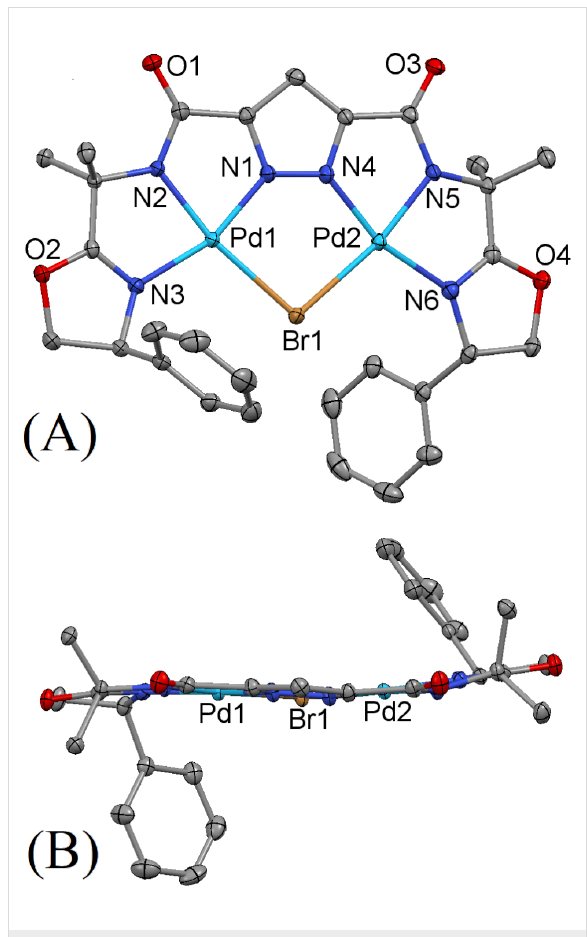
Figure 5: Thermal ellipsoid plot (50% probability) of the molecular structure of 30 ·Pd 2 Br. Hydrogen and solvate atoms have been omitted for clarity: (A) view normal to the mean molecular plane; (B) side view nearly perpendicular to (A) to allow a better view of the region of open access to the metal site. The complex 30 ·Pd 2 Br crystallizes in the monoclinic space group P 2 1 with a = 9.8982(7) Å, b = 10.0139(7) Å, c = 16.9675(12) Å, α = 90°, β = 101.277(1)°, γ = 90°, V = 1649.3(2) Å 3 , Z = 2, D c = 1.847 mg m − 3 and μ (Mo K α ) = 2.510 mm − 1